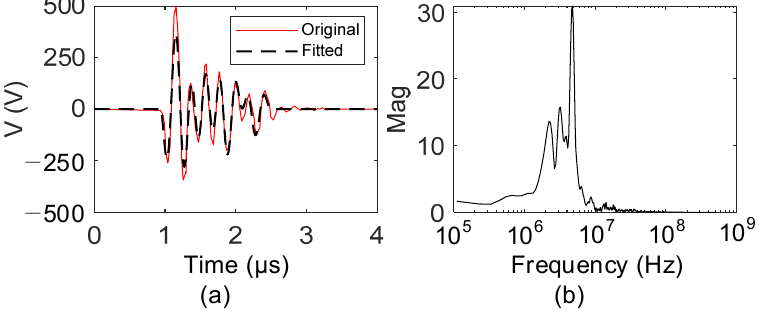
Figure 9. PD signal from the PD generator. ( a ) Mimicked PD signal and its fitted curve and ( b ) fast Fourier transform of the mimicked PD signal.